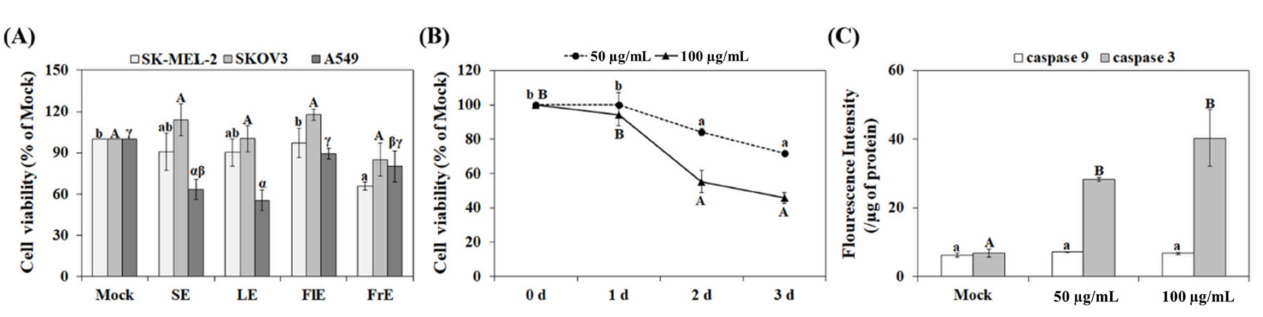
Figure 2. Anticancer effects of R . rugosa organ extracts on human cancer cell lines. ( A ) Effect of R . rugosa organ extracts on human cancer cell viability, as determined by the MTT assay. ( B ) Time- and dose-dependent effect of LE on the viability of A549 cells. ( C ) Effect of LE on caspase-3 or caspase-9 activity in A549 cells. DMSO-treated samples were used as mock controls. The plots represent the mean ± SE of three independent experiments. Different letters indicate significant differences between groups ( p < 0.05). Stem extract, SE; leaf extract, LE; flower extract, FlE; fruit extract,